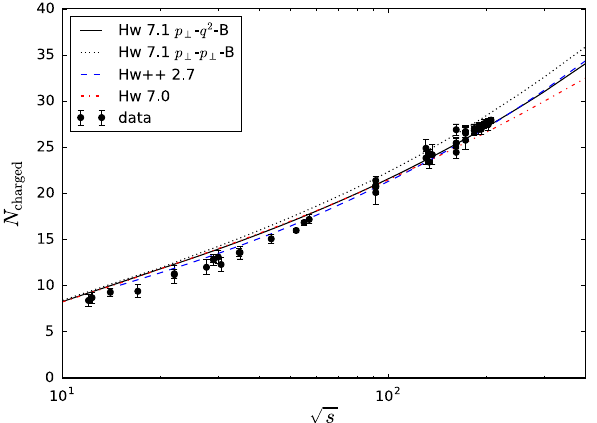
Fig. 11 The evolution of the number of charged particles in gluon jets as a function of twice the energy of the gluon